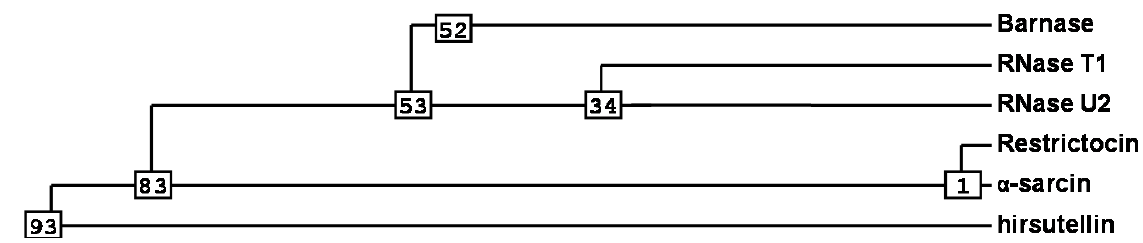
Figure 2. Phylogenetic analysis [42] for the most important members of the Barnase superfamily. Numbers shown in the phylogram are distances corresponding to the amino acid sequence alignment of Figure